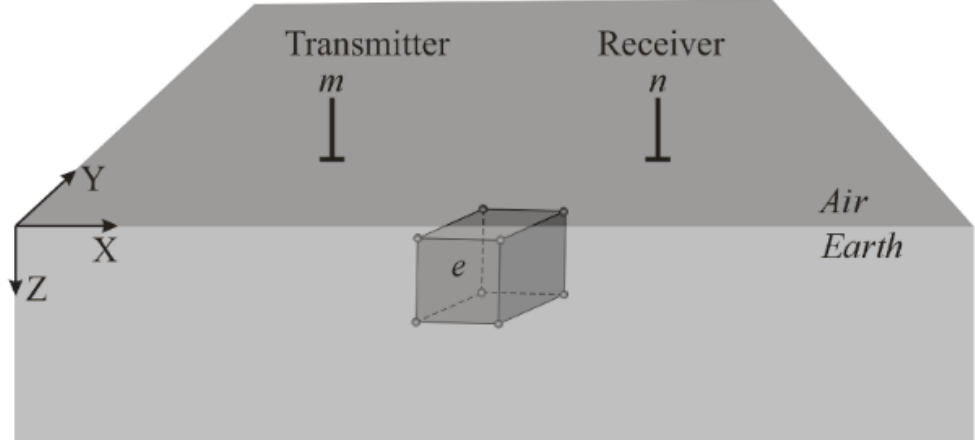
Figure A1. Relative location of a transmitter and a receiver located on nodes of the 3-D mesh with a hexahedral element in order to calculate the partial derivative of potential between the points m and n versus the element’s conductivity ∂ V nm